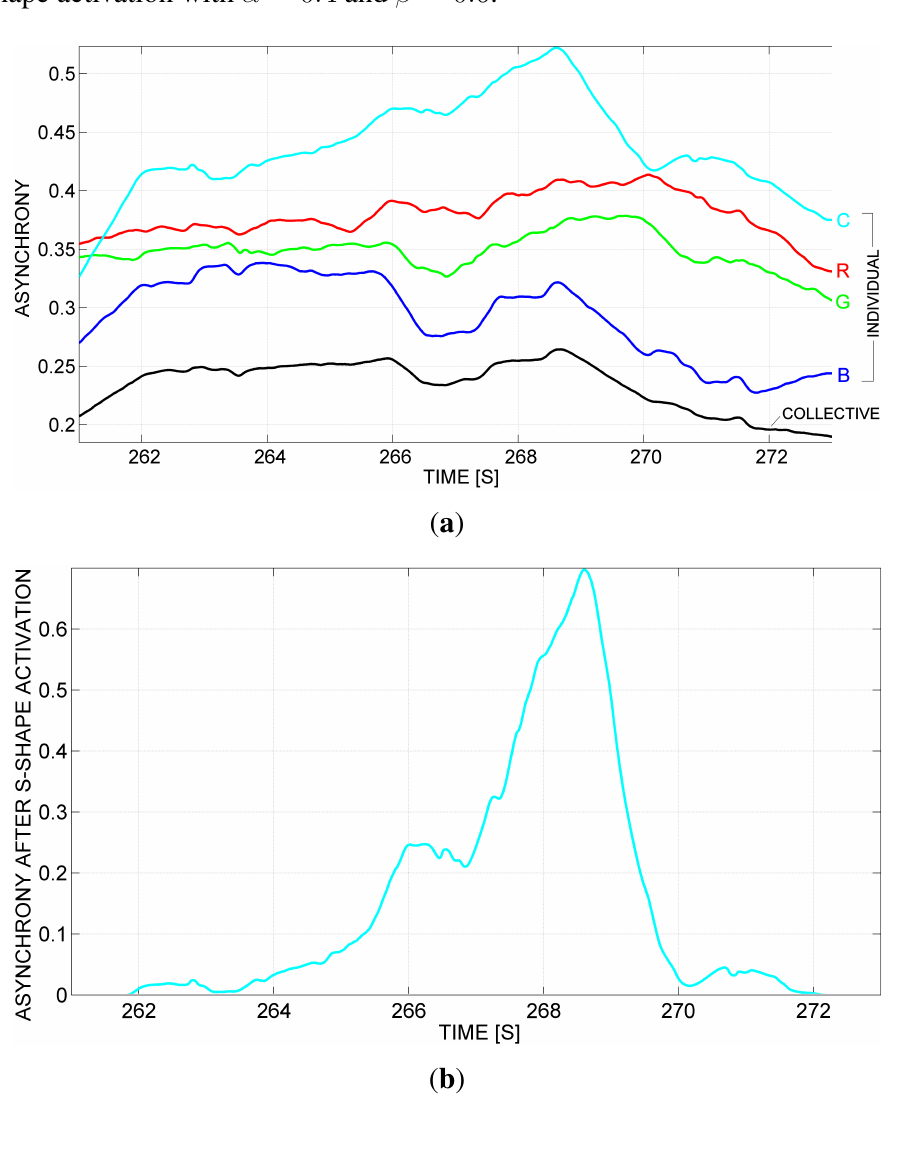
Figure 13. An s -shape activation function, with α = 0 . 3 and β = 0 . 7